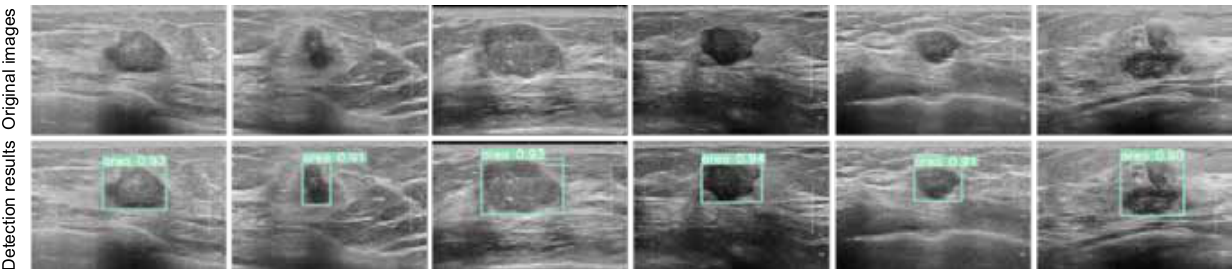
Figure 6 Examples of breast cancer detection using the YOLO method.